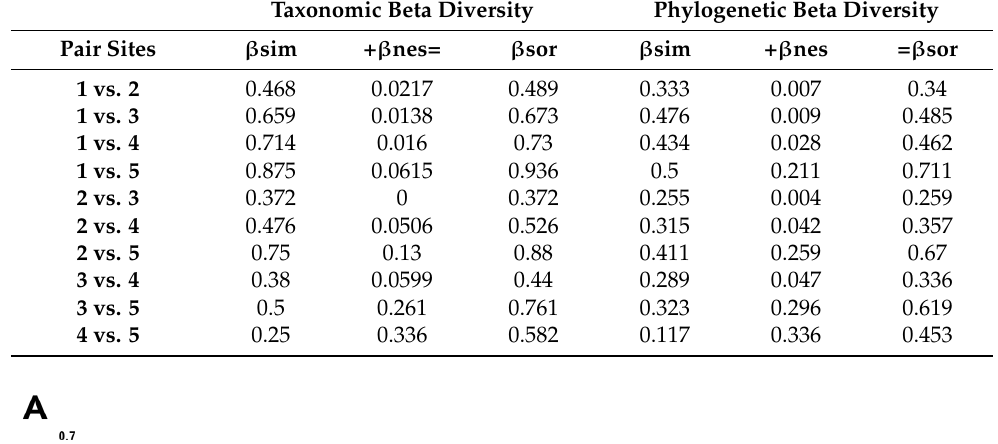
Table 2. Total taxonomic and phylogenetic beta diversity (total dissimilarity [βsor]) as the sum of its components (turnover [βsim] and nestedness [βnes]) for the Neuropteran community along an elevational gradient of the Tacaná Volcano.